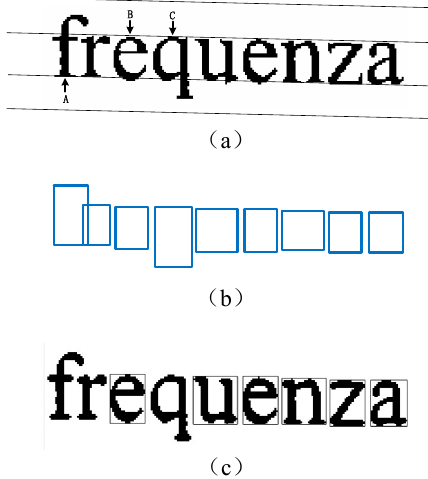
Figure 3. Filter A and C type letters: ( a ) the English world with all types of letters; ( b ) the bounding boxes of all letters; ( c ) the ECCs after filtering by using bounding